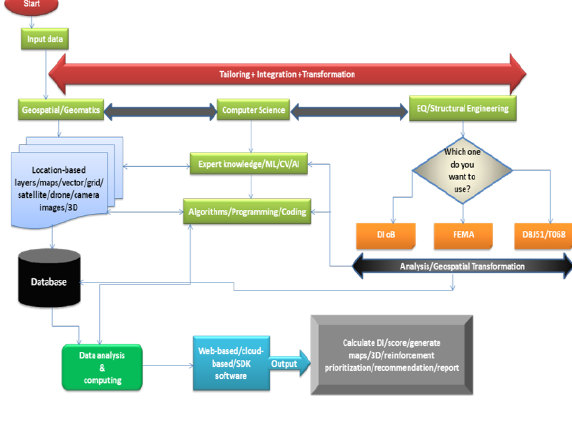
Figure 4. Flowchart of the